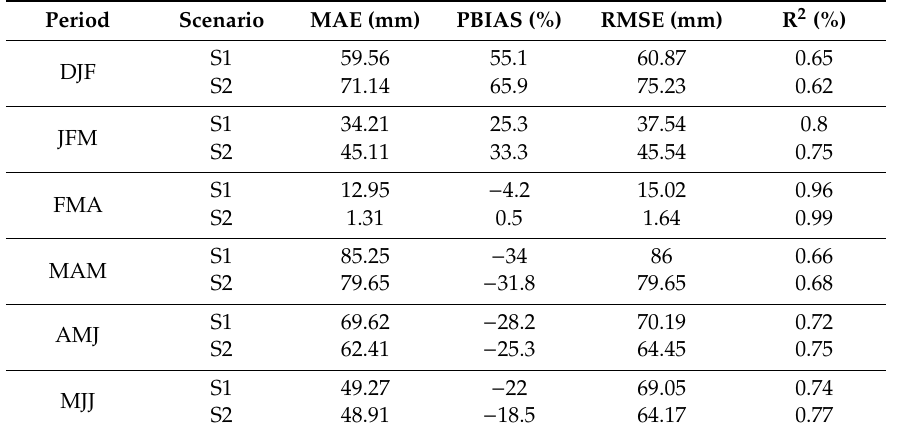
Table 5. Statistical and e ffi ciency indicators for the evaluation of prognostic performance in R1. Period